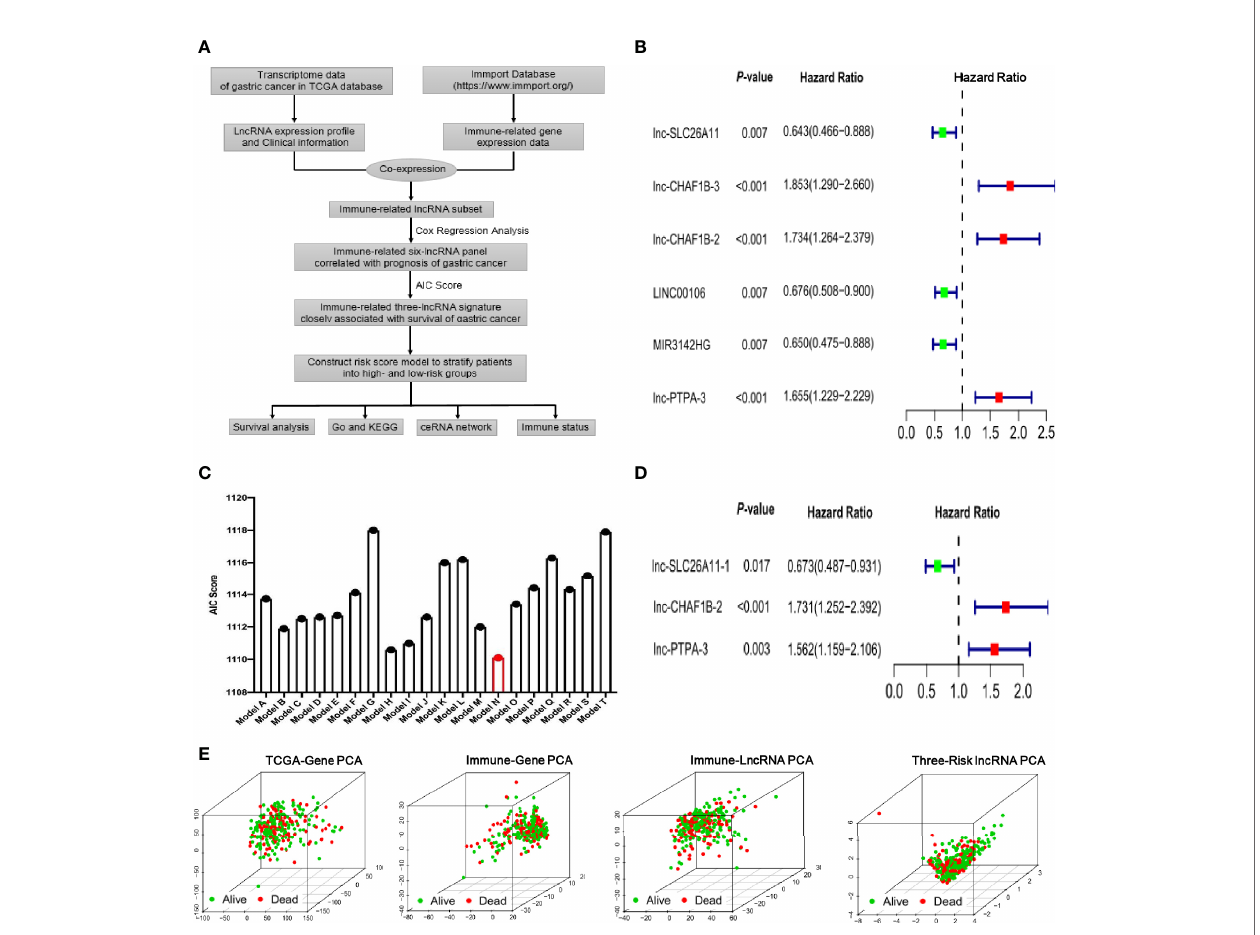
FIGURE 1 | Identi fi cation of the immune-related lncRNA signature in gastric cancer. (A) Flowchart of identifying immune-related lncRNA signature derived from TCGA transcriptome of gastric cancer and Immport database. (B) Forest plot of the six lncRNAs by univariate cox regression analysis. (C) Akaike ’ s information criterion (AIC) scores of different lncRNA combination models and Model N is the best lncRNA signature with the lowest AIC score. (D) The multivariate analysis forest plot of Model N, which is composed of three immune-related lncRNAs as indicated in the fi gure. (E) Principal components analysis (PCA) showed survival status among four different gene sets including all genes of TCGA, immune genes of Immport database, immune-related lncRNAs and the identi fi ed three-risk lncRNA signature as indicated in the fi